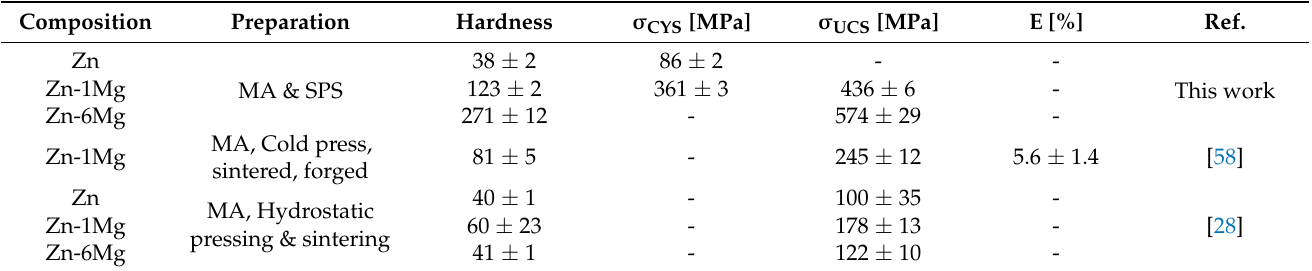
Table 5. Mechanical properties of zinc and its alloys prepared by powder